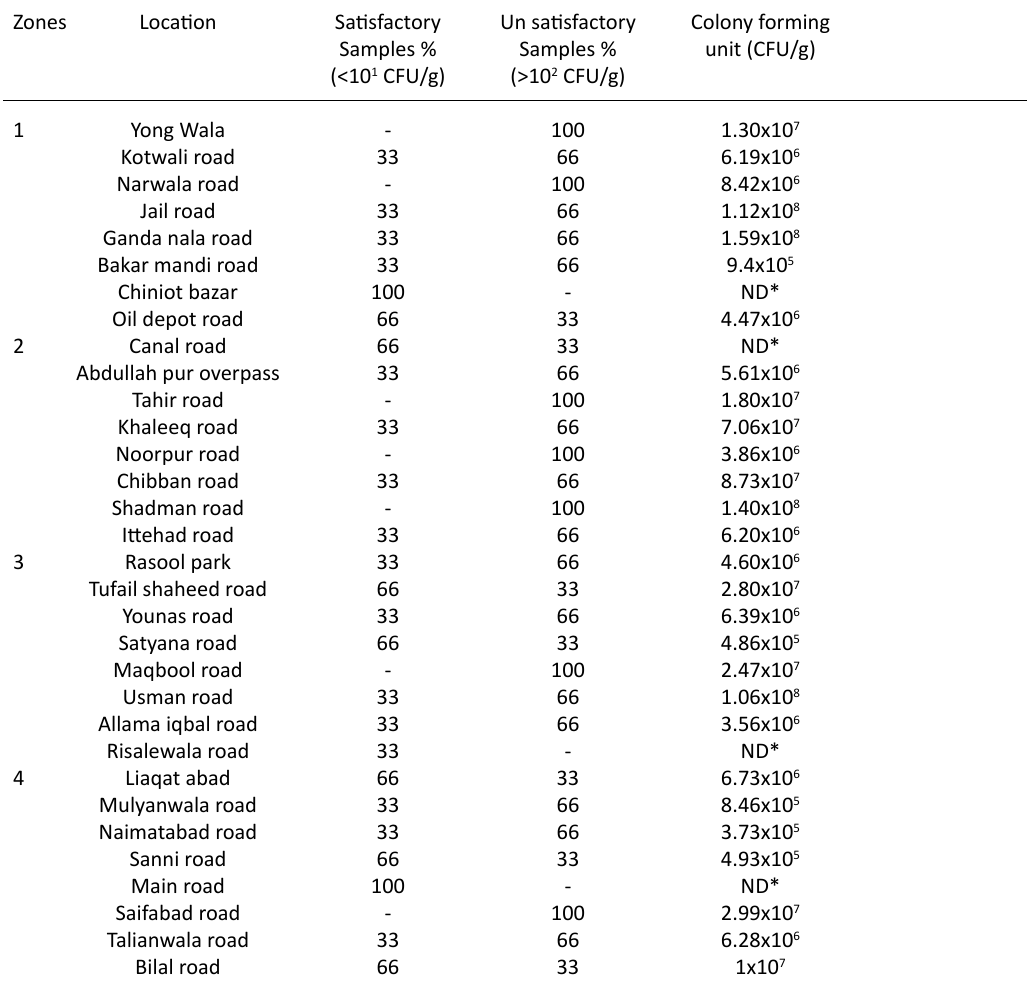
Table 3. Prevalence and enumeration of Listeria in vegetable salad Zones Location